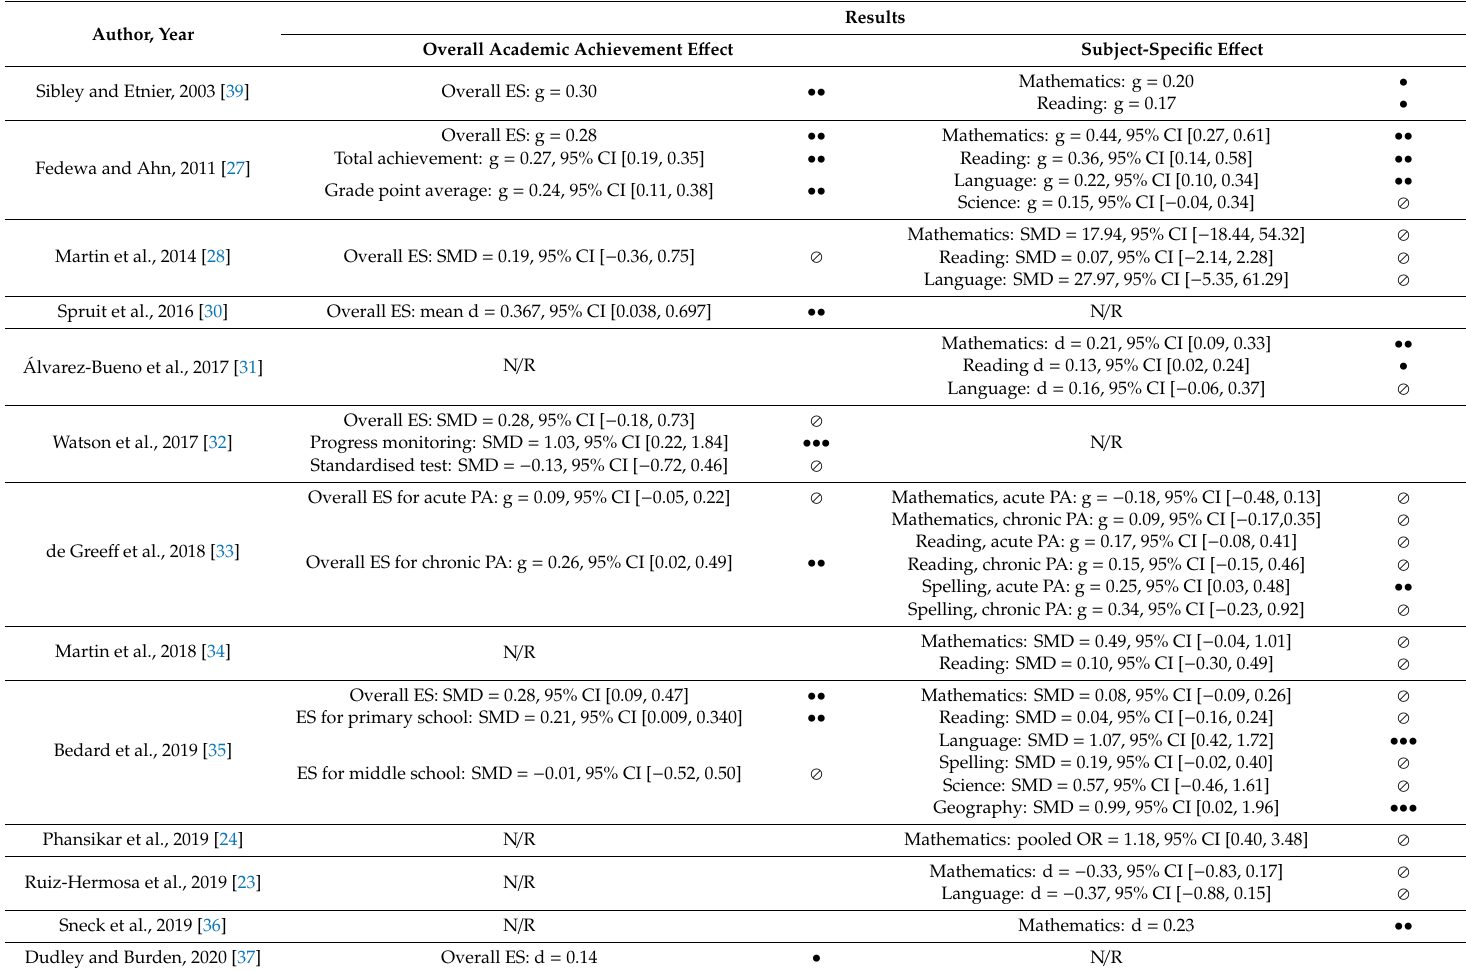
Table 3. Summary of e ff ect sizes retrieved from the